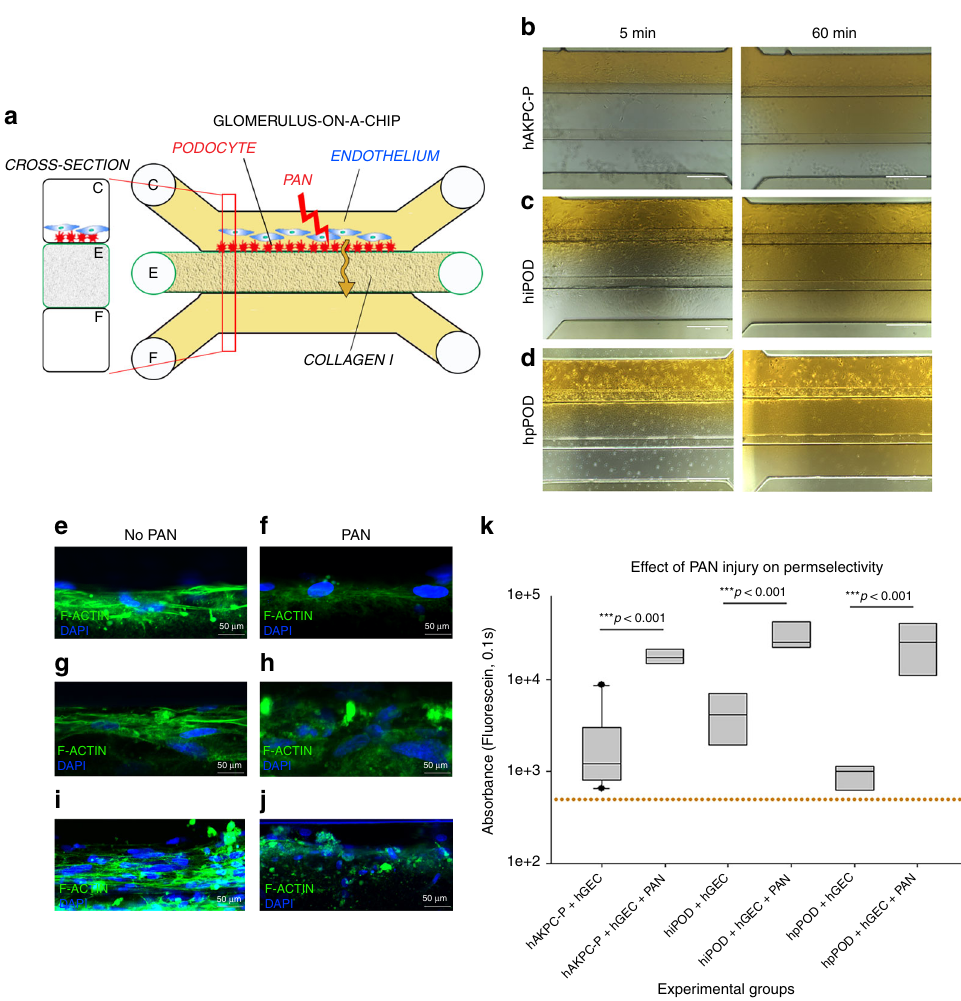
Fig. 4 GOAC and puromycin aminonucleoside (PAN) injury. a Representation of GOAC albumin permselectivity assay following PAN injury: PAN (5-day induction, 10 mg/ml) is applied to channel C followed by albumin-FITC (40 mg/ml, yellow) and fl ow-through collected in channel F. b – d Bright fi eld showing albumin leakage (yellow) after 5 min (left columns) and 60 min (right columns) in hAKPC-P + hGEC chip ( b ), in hiPOD + hGEC chip ( c ), in hpPOD + hGEC ( d ) after PAN injury. Marked albumin leakage occurs following podocyte injury. e – j Damage to podocytes was assessed by F-actin staining in hAKPC-P + hGEC chip before ( e ) and after PAN damage ( f ), in hiPOD + hGEC chip before ( g ) and after PAN damage ( h ), and in hpPOD + hGEC before ( i ) and after PAN damage ( j ) con fi rming widespread disruption of the cytoskeleton. Nuclei are stained with DAPI (blue); actin fi laments stained with phalloidin (green). All pictures: scale bar = 50 µ m; k box plot graph of fl uorescein absorbance (expressed as log) in fi ltrate collected after 60 min after 5 days exposure to PAN. For all experimental groups, a marked and statistically signi fi cant increase was found in albumin permeability following